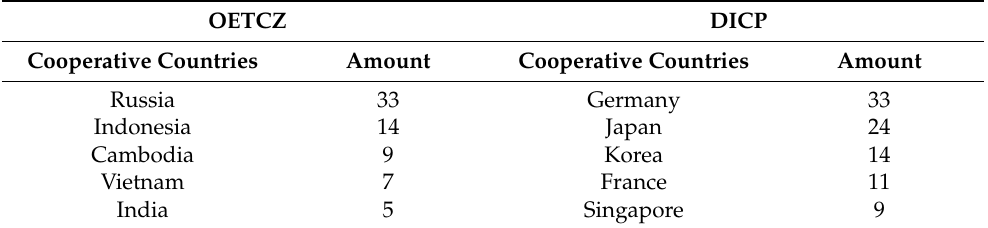
Table 1. Top five counterpart countries cooperating with China in the form of OETCZs and DICPs. OETCZ DICP Cooperative Countries Amount Cooperative Countries Amount